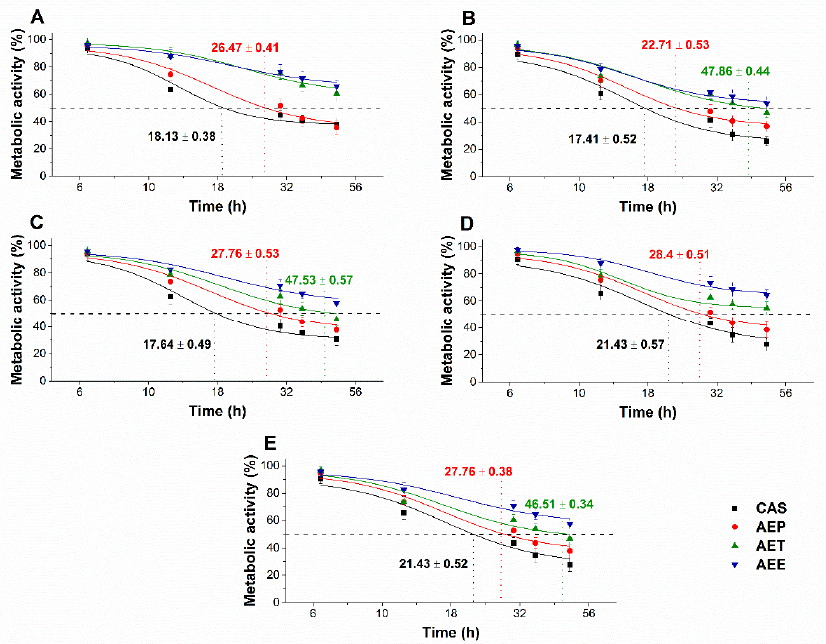
Figure 16. Effects of AEP, AET and AEE at their MEC 10 concentrations on the metabolic activities of the planktonic S. pombe ( A ), C. albicans ( B ), C. tropicalis ( C ), C. dubliniensis ( D ) and C. krusei ( E ) compared to their respective 0 h samples and caspofungin (CAS) standard antimicrobial controls after 6, 12, 30, 36 and 48 h of treatment (mean ± SD, n = 6 independent experiments, each with three technical replicates).